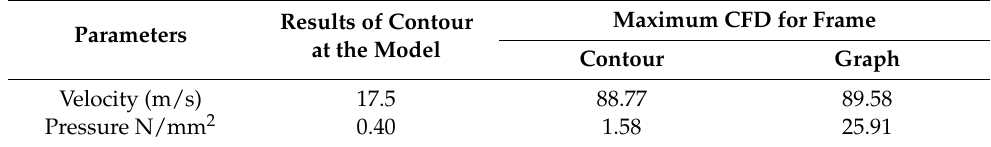
Table 9. Simulation CFD results for the IBS